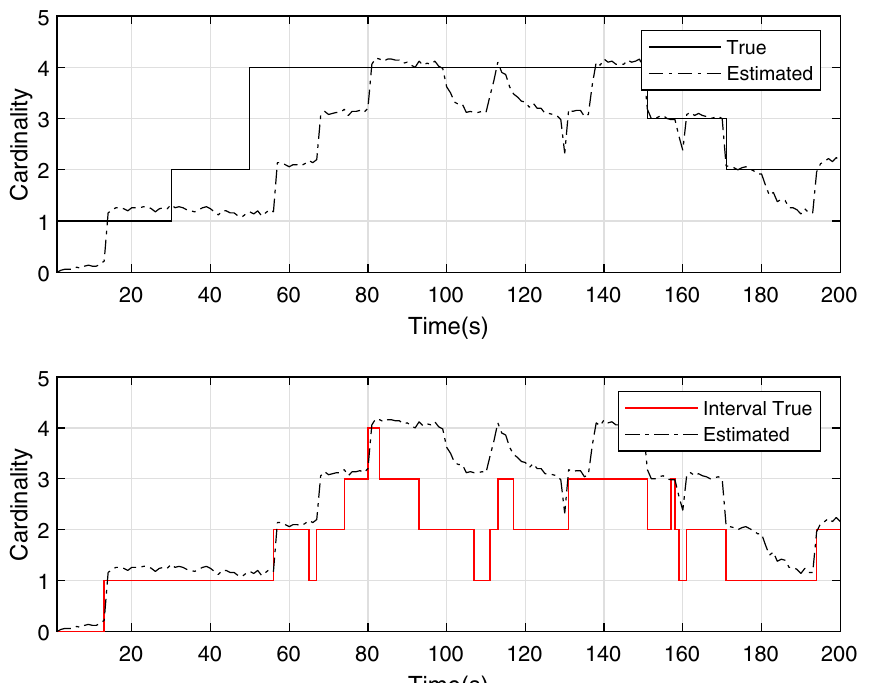
Fig. 5 The estimation of the number of